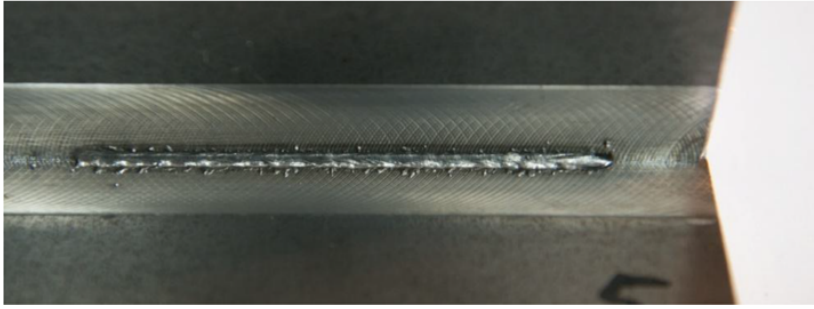
Figure 8. Double ‐ sided T ‐ joint with the proper weld face.